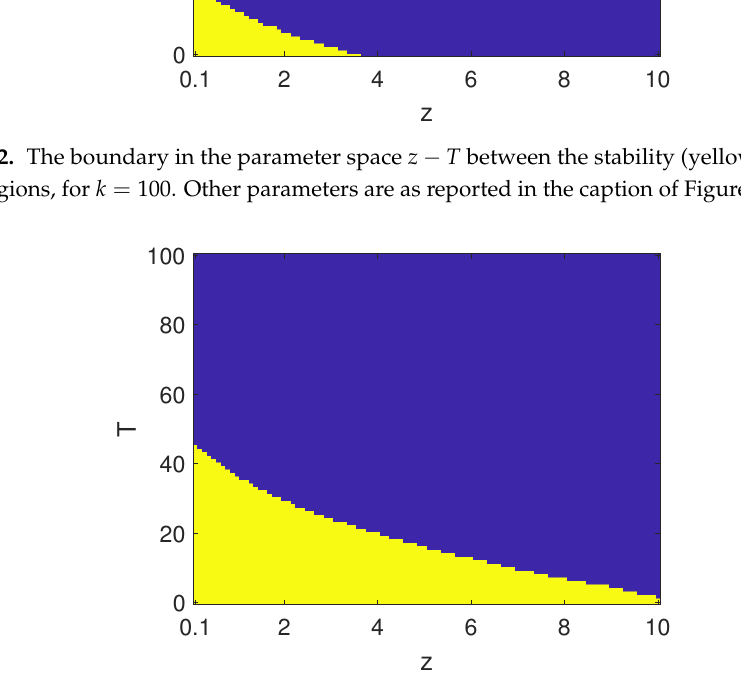
Figure 13. The boundary in the parameter space z − T between the stability (yellow) and instability (blue) regions, for k = 40. Other parameters are as reported in the caption of Figure